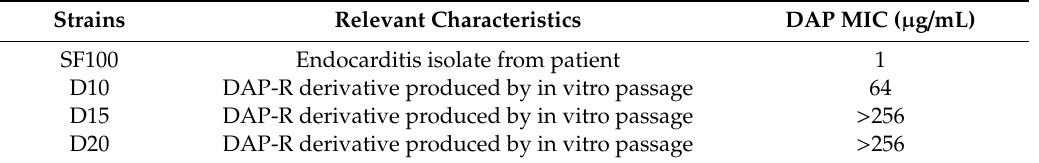
Table 1. List of S. mitis-oralis strains and their daptomycin (DAP)